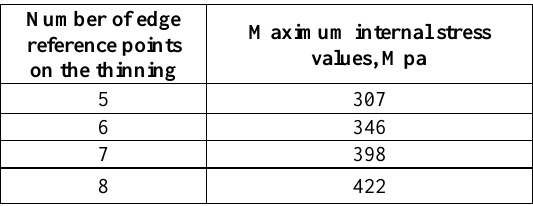
Fig. 3. The results of engineering analysis of structures with 8,7,6 and 5 control points Table 1. The results of the internal stresses of each